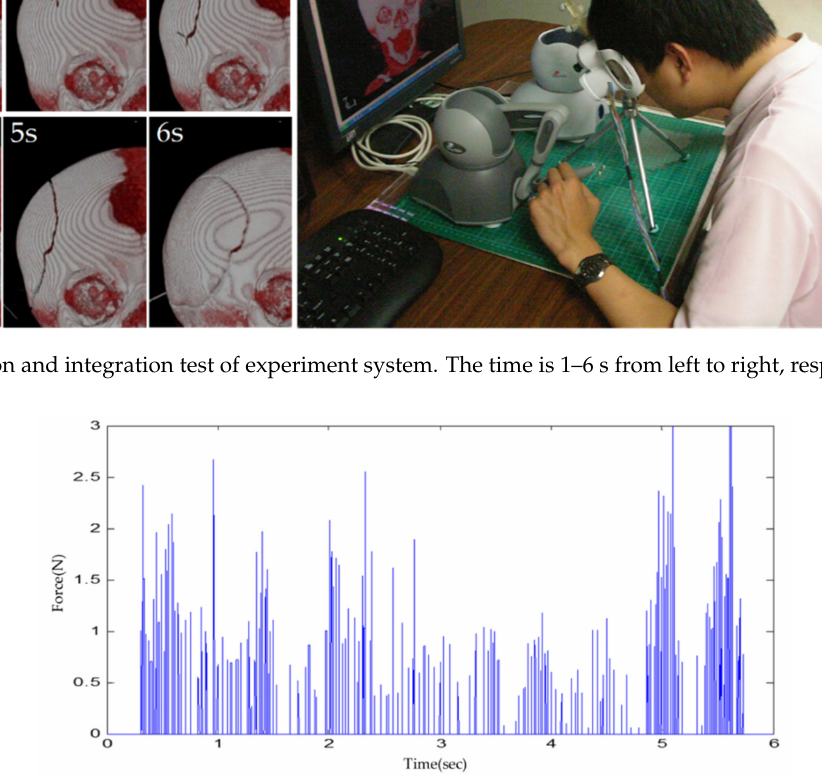
Figure 7. Skull remodeling simulations and reaction force feedback corresponding to Figure 6.